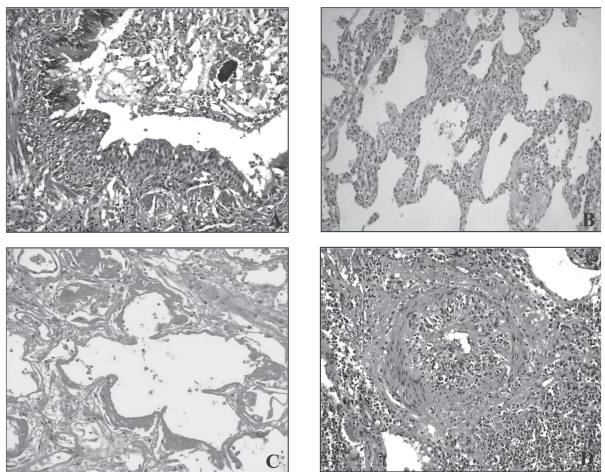
Figure 4 - Prototypical histopathological changes: A (HE, 200X): chronic bronchiolitis with squamous metaplasia; B (HE, 200X): non-specific interstitial pneumonia (cellular pattern); C (HE, 200X): diffuse alveolar damage; D (HE, 200X): chronic vasculitis